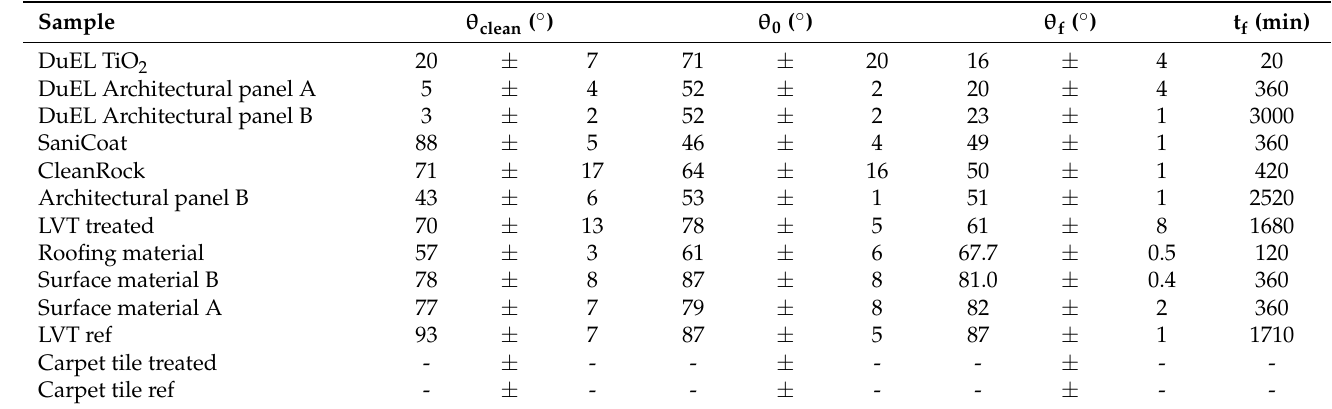
Table 1. Overview of the water contact angles of the clean, pre-treated, unfouled surface ( θ clean ), the oleic-acid-fouled surface before UV irradiation ( θ 0 ), the final contact angle after UV irradiation ( θ f ) and irradiation time needed. A dash (-) is used for values that could not be measured.